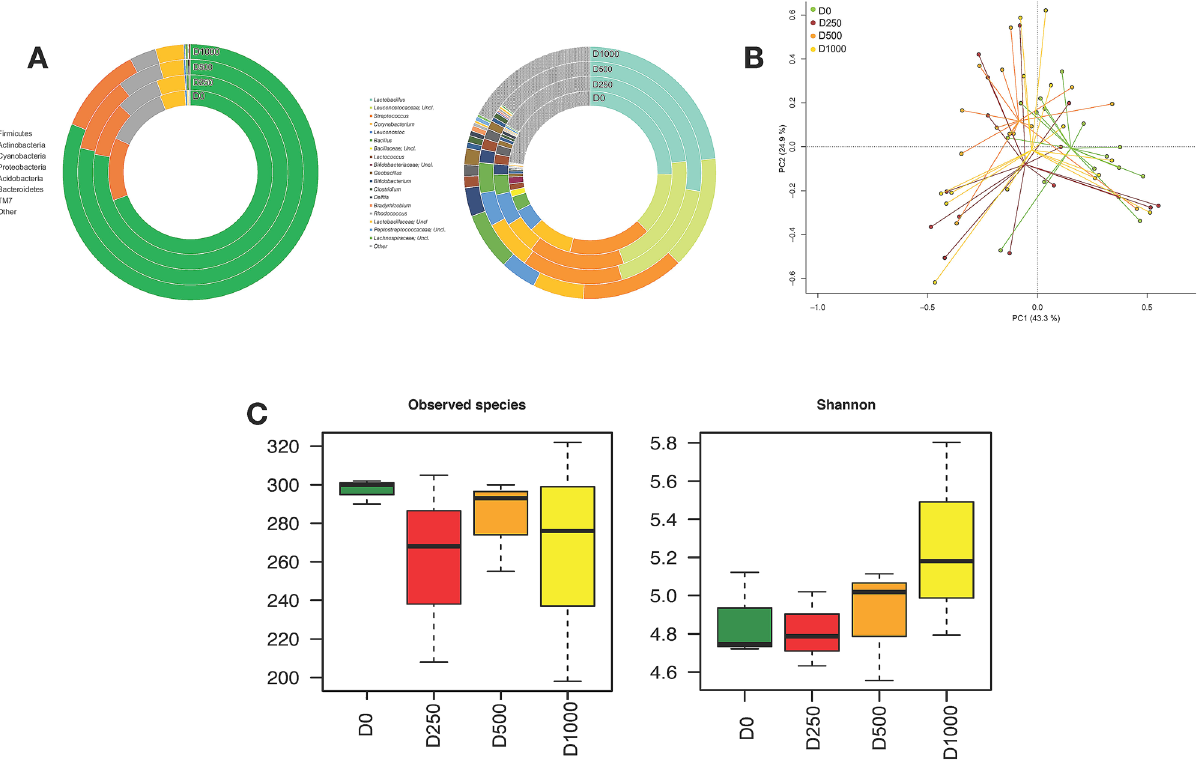
Figure 3. Autochthonous intestinal microbiota from sea bass Dicentrarchus labrax fed with control diet (D0) and different doses of microencapsulated OA and NIC (D250, D500 and D1000). ( A ) Average phylogenetic profiles of the gut microbiome of sea bass are provided at phylum (left) and genus (right) level; Phyla and genus which represent < 1.5% of the autochthonous community were included in ‘Others’. ( B ) Principal Component Analysis (PCA) of the Euclidean distance of sea bass gut microbial ecosystem after the assumption of different diets (D0, D250, D500 and D1000). A significant separation among groups was observed [P value = 0.03; Permutation test with pseudo-F ratios (Adonis)]. ( C ) Alpha diversity of the sea bass GM for all diet assumption was estimated with observed species and Shannon metrics.